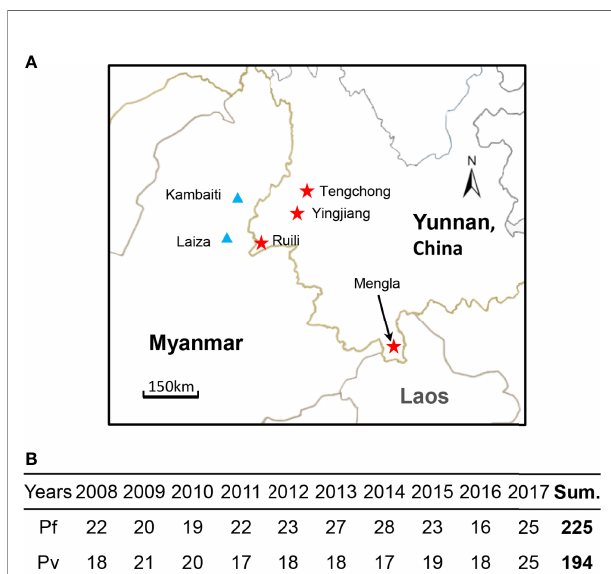
FIGURE 1 | Information about blood samples. (A) Geographic locations of blood samples. The red star represents the region of Yunnan, China, and the blue triangles represent the region of Myanmar. The map was produced using Photoshop. (B) The number of P. falciparum - and P. vivax -infected malaria patient samples in 10 years from 2008 to